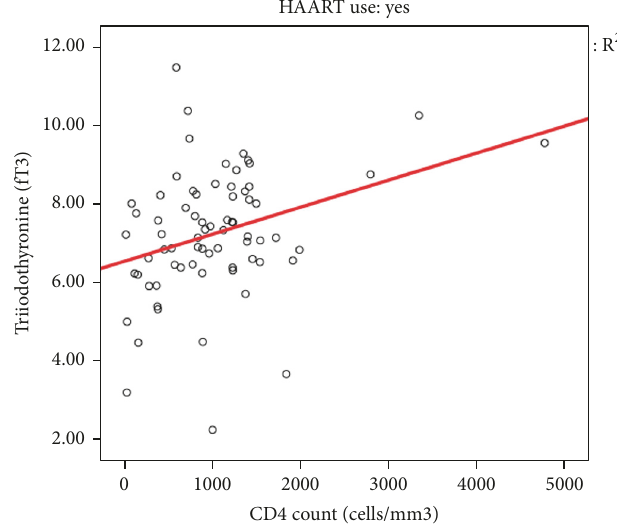
Figure 1: Thyroid hormone level and CD4 count.